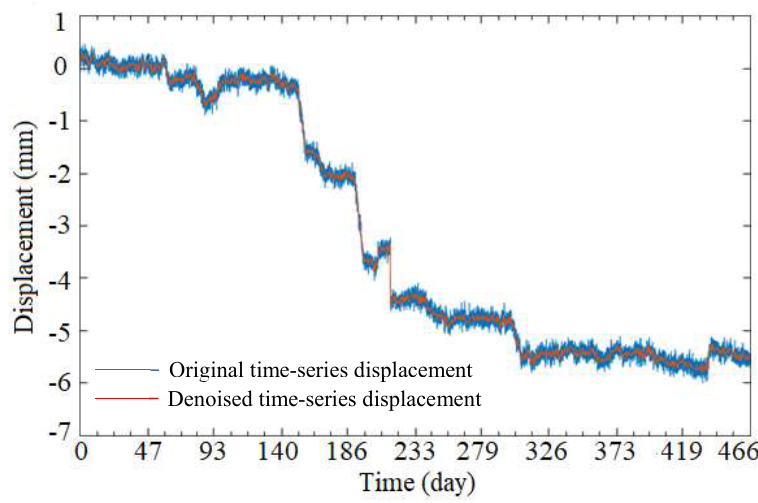
Figure 10. Comparison between the original signal and the denoised signal.